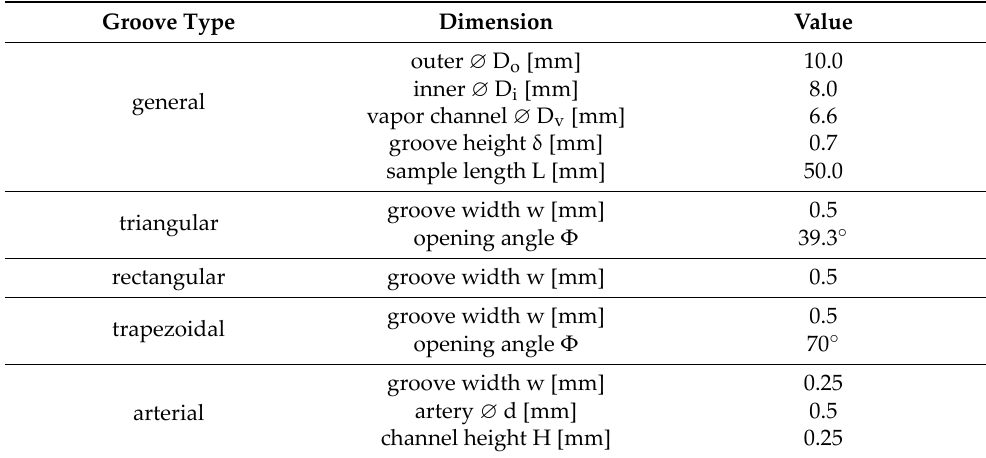
Table 2. Contour parameters for grooved wicks, with parameters P1 and P2 as contour parameters commonly used for bulk material with different surface roughnesses, and parameters P3, P4, and P5 adapted for printing filigree structures.